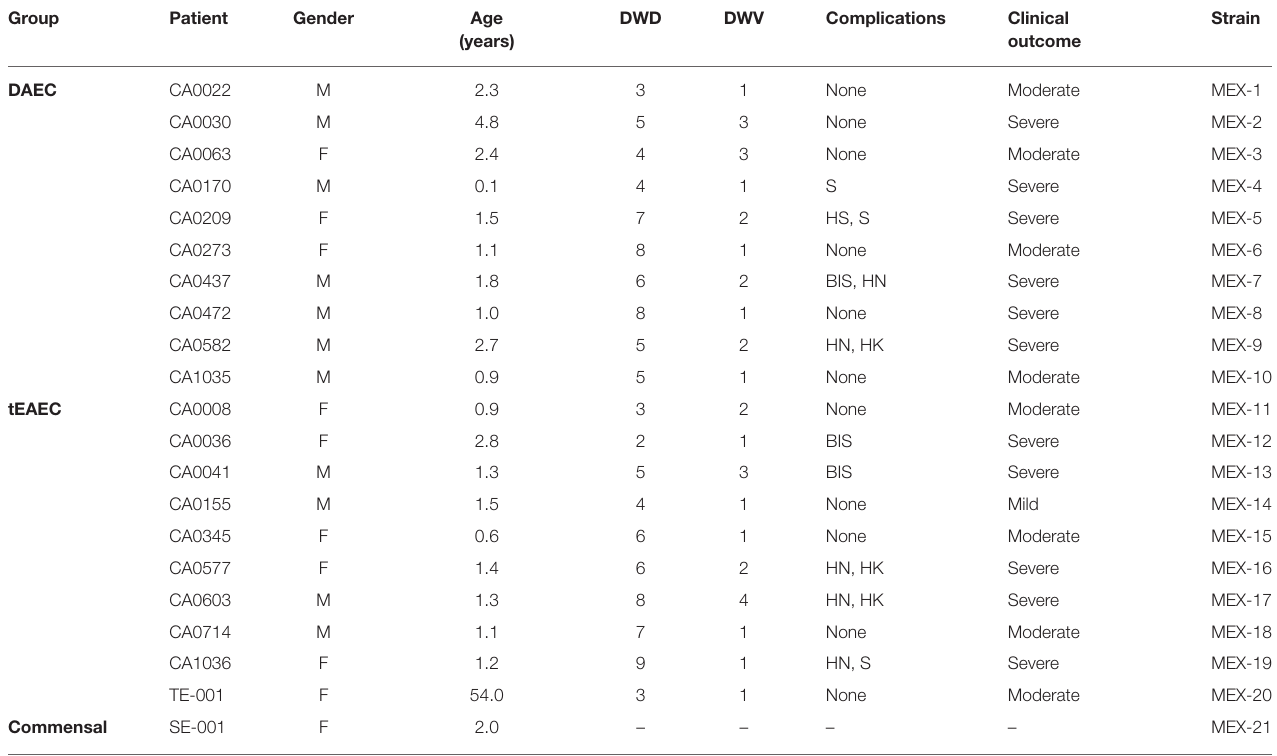
TABLE 1 | Patient’s clinical profile and strains genome characteristics.